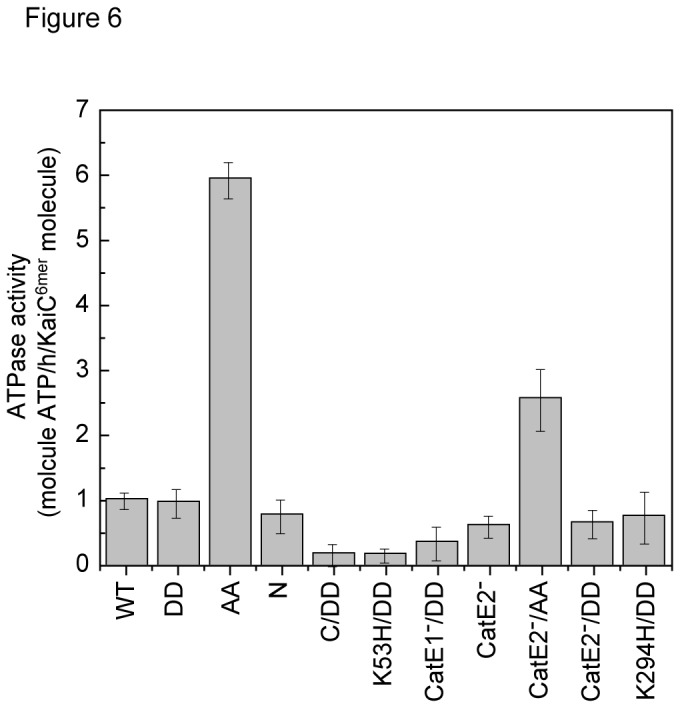
Effects of mutations in the ATPase motifs and phosphorylation sites of KaiC on KaiC’s ATPase activity.We incubated 1 μM KaiCs6mer with Mg-ATP in reaction buffer at 4 °C for 6 h and then measured ATPase activities. Values are means ± SD from triplicate assay. KaiCs6mer: WT, KaiCWT
6mer; DD, KaiCDD
6mer; AA, KaiCAA
6mer; N, KaiCN
6mer; C/DD, KaiCC/DD
6mer; K53H/DD, KaiCK53H/DD
6mer; CatE1-/DD, KaiCCatE1-/DD
6mer; CatE2-, KaiCCatE2-6mer; CatE2-/AA, KaiCCatE2-/AA
6mer; CatE2-/DD, KaiCCatE2-/DD
6mer; K294H/DD, KaiCK294H/DD
6mer.